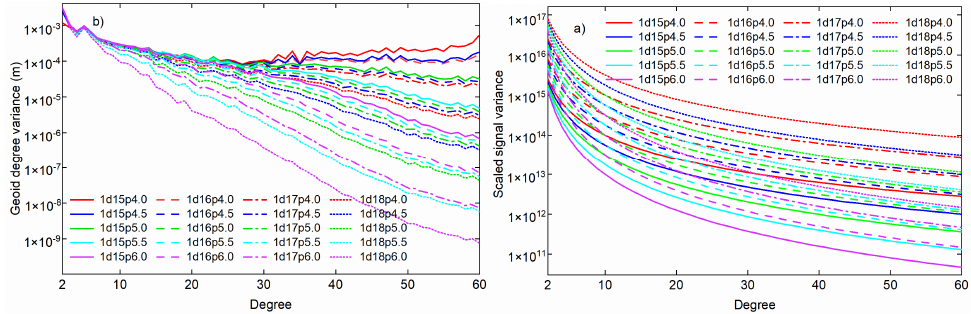
Figure 16. The degree variances of different regularization coefficients and different power indices: ( a ) the signal variances scaled with regularization coefficients; ( b ) the geoid degree variances of filtered solution.